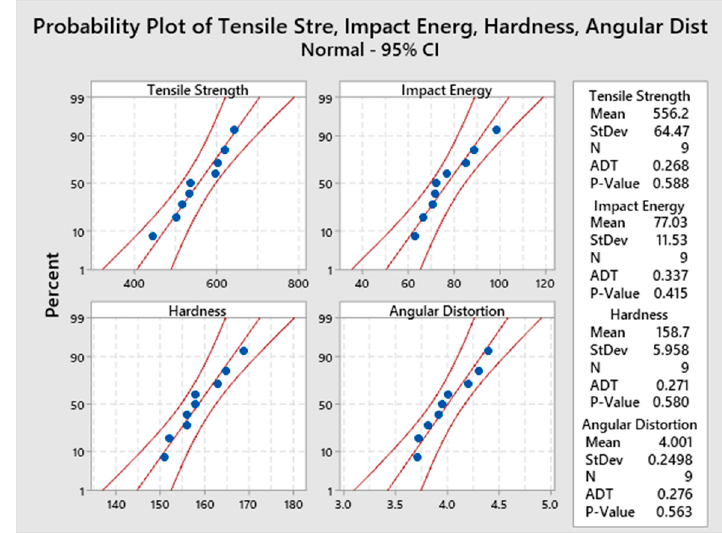
Figure 6. Normal probability plots of responses.